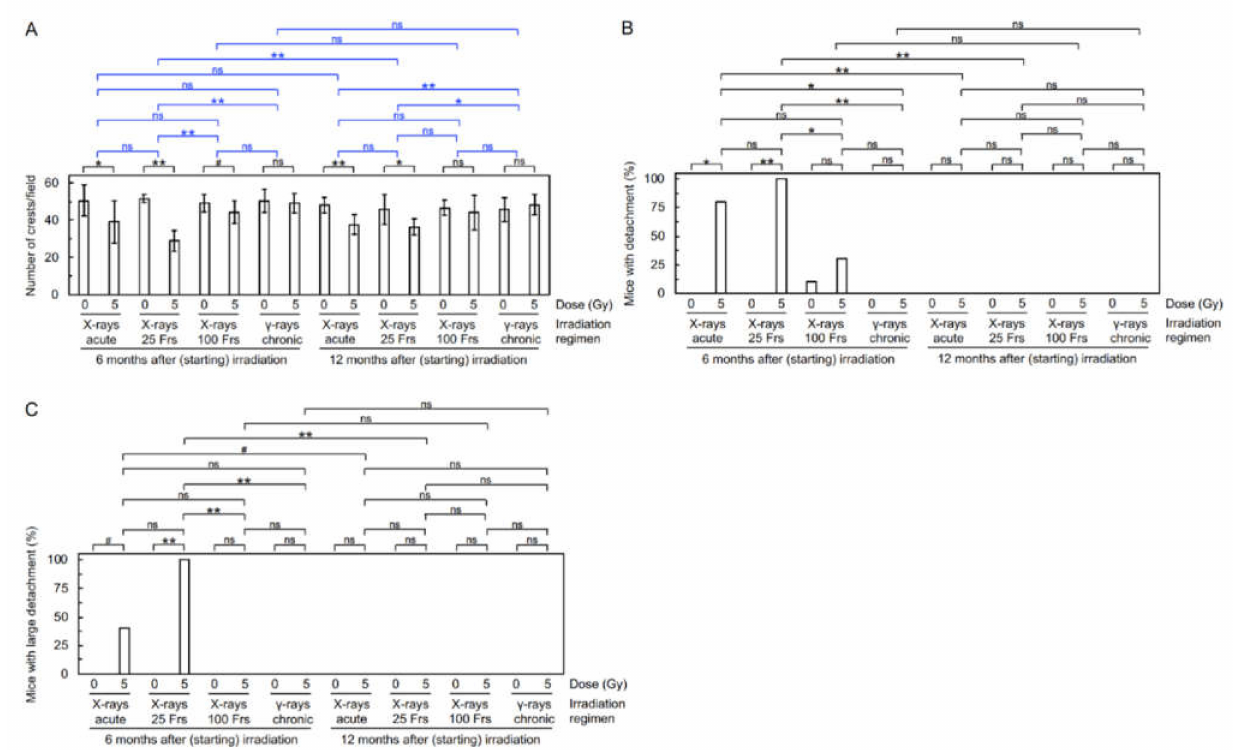
Figure 1. Morphological alterations in the aortic endothelium. Quantitative analysis for ( A ) the number of crests/field, ( B ) percentage of mice with detachment, and ( C ) percentage of mice with large detachment (8–10 mice/group analyzed, Welch’s t -test for A , Fisher’s exact test for B , C ). Frs, fractions. **, p < 0.001. *, 0.001 ≤ p < 0.05. #, 0.05 ≤ p < 0.1 (marginally significant). ns, p ≥ 0.1 (nonsignificant). See footnote in Supplementary Materials for an outline of statistical